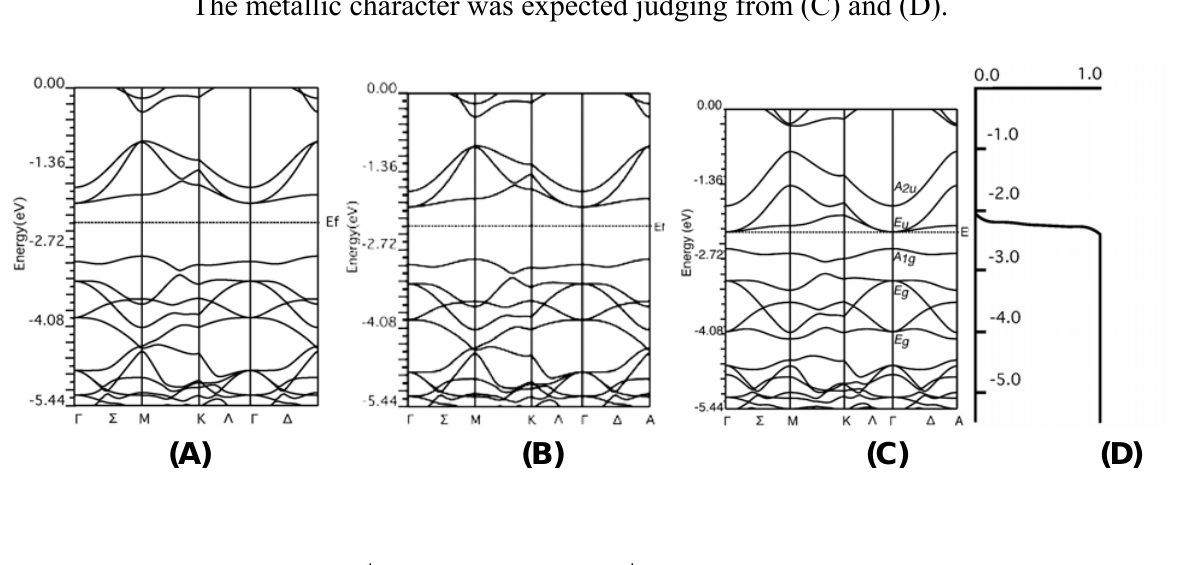
) with variation of distortion parameter F